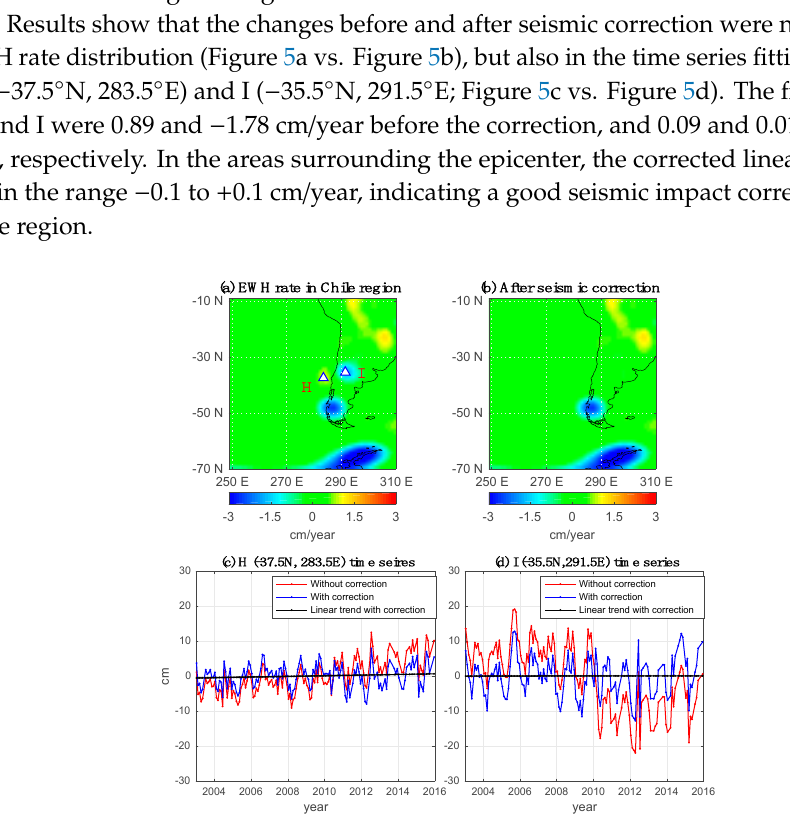
Figure 5. ( a ) The equivalent water height rate distribution in the Chile earthquake region, ( b ) the rate distribution after the seismic effect correction; ( c ) the time series at the point H (-37.5°N, 283.5°E); and ( d ) the time series at the point I (-35.5°N, 291.5°E). Finally, we corrected the seismic effects in the Chile earthquake region. Similar to that in the Tohoku-Oki earthquake region, we used Equation (1) (see Section 2) to correct the seismic effect in this region. The correction region ranged from -41°N to -31°N in latitude and from 277°E to 297°E in longitude. Results show that the changes before and after seismic correction were noticeable, not only in the EWH rate distribution (Figure 5a vs. Figure 5b), but also in the time series fitting